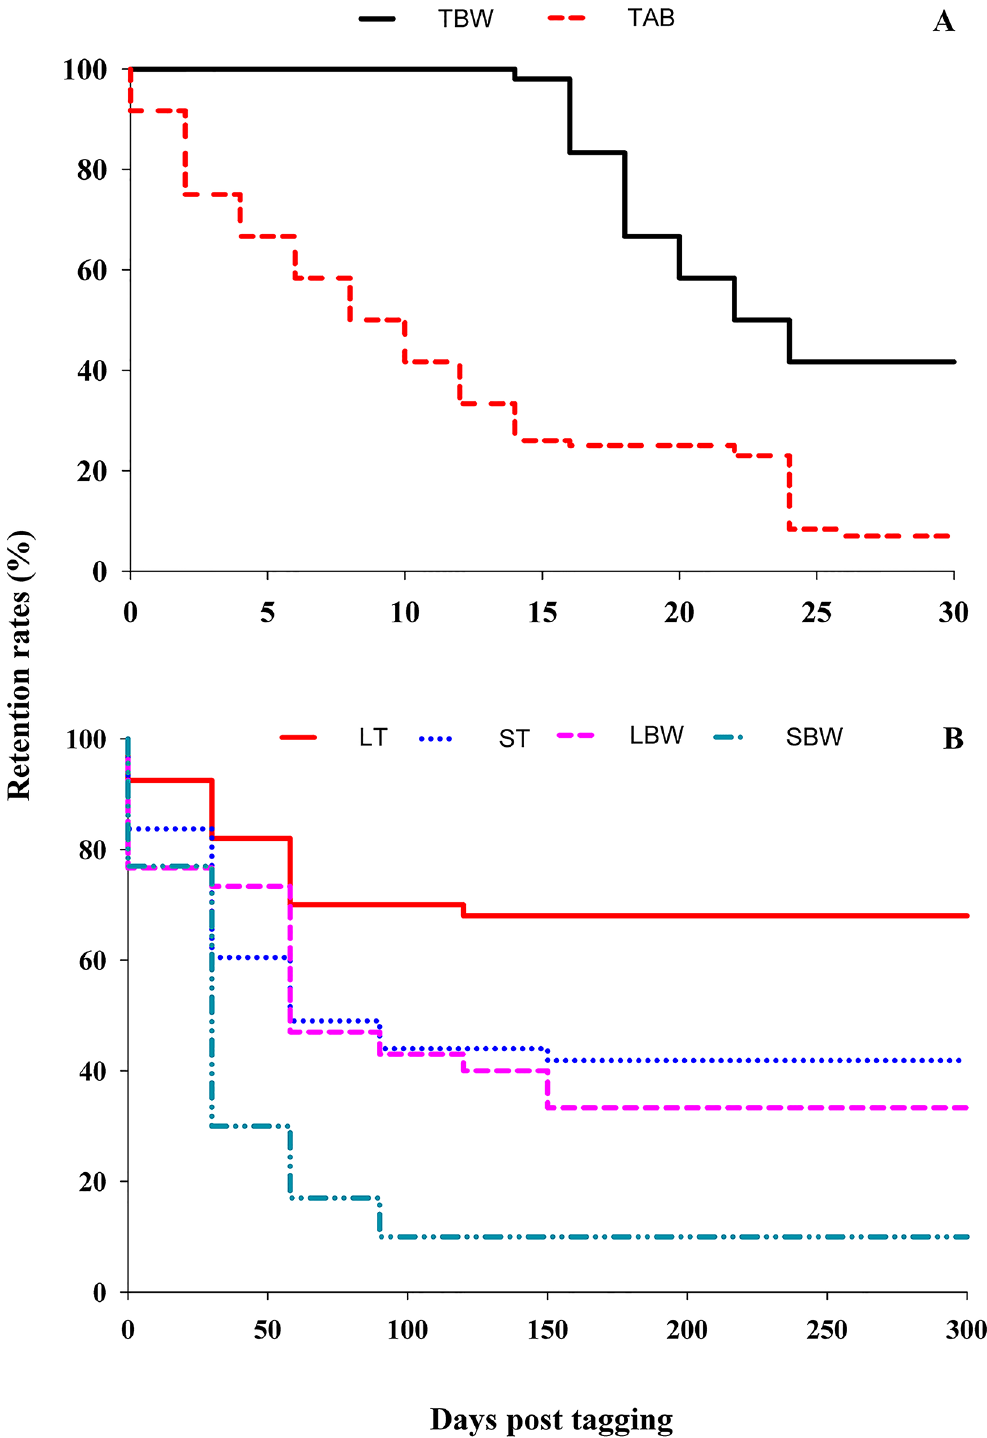
Fig 1. PIT tag retention rates in sea cucumbers. (A) Retention rates of tags implanted in the body wall and aquapharyngeal bulb during the short-term experiment. (B) Retention rates of tags implanted in the tentacles and body wall during the long-term experiment. TBW, tagged in body wall; TAB, tagged in aquapharyngeal bulb (directly); LT, large individuals tagged in tentacle (to aquapharyngeal bulb); ST, small individuals tagged in tentacle (to aquapharyngeal bulb); LBW, large individuals tagged in body wall; SBW, small individuals tagged in body wall.